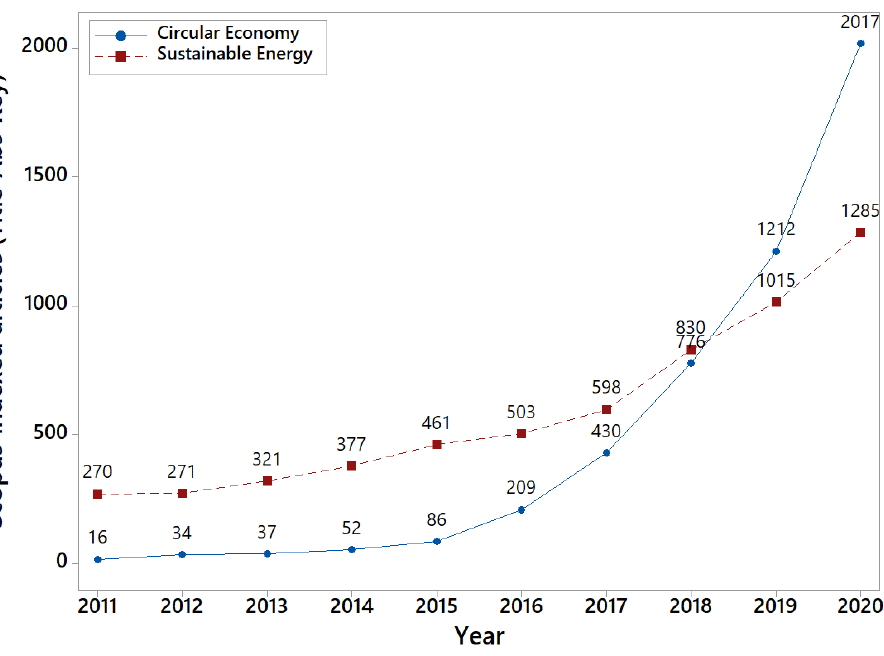
Figure 1. Scopus-indexed articles including “circular economy” or “sustainable energy” in T-A-K.